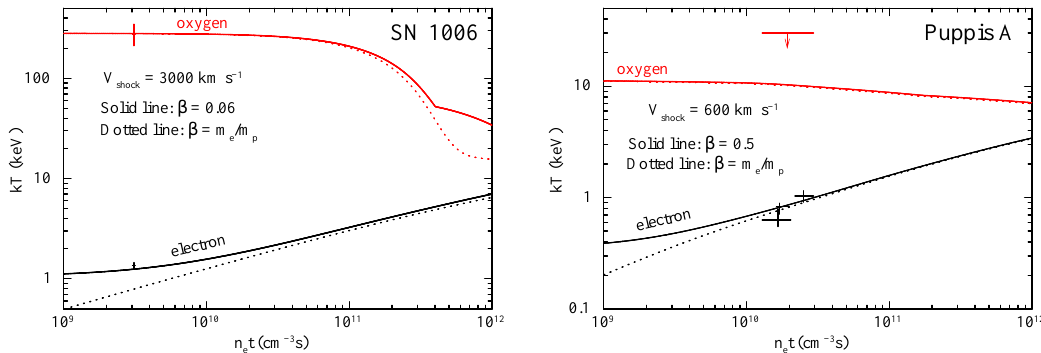
Figure 2: Temperature histories for electrons (black) and oxygen (red) as a function of n e t . Left and right panels are for the NW knot in SN 1006 and the ejecta knot in Puppis A,